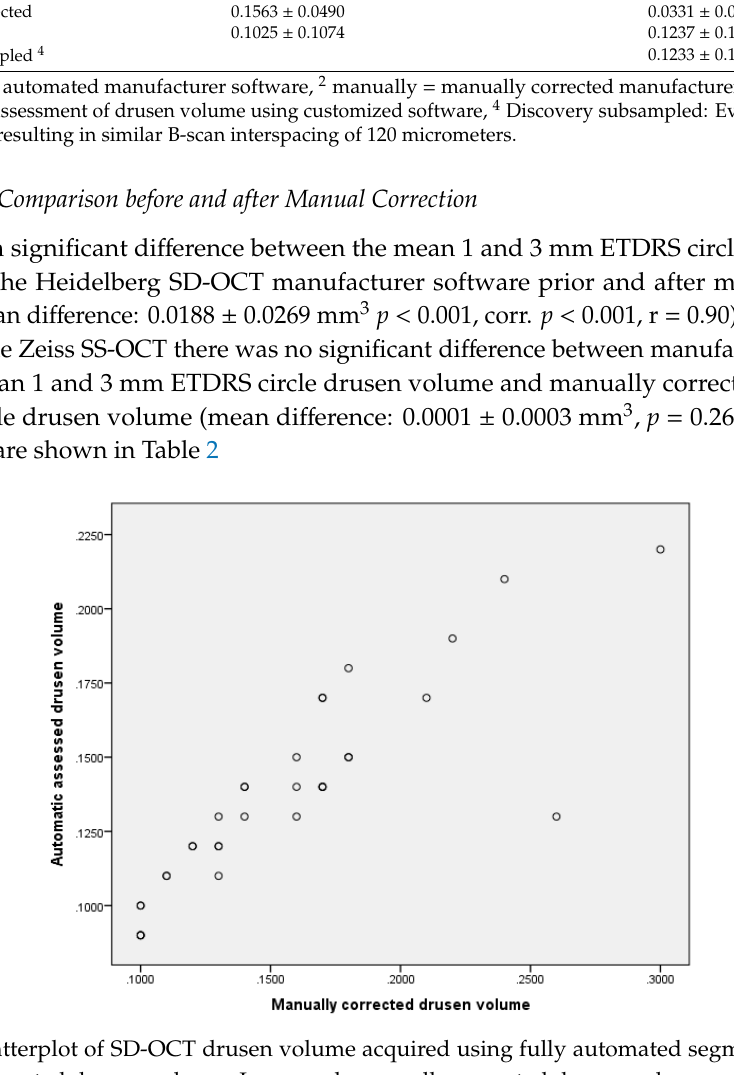
Table 1. Mean measurements for central 1 and 3 mm ETDRS circle drusen volume.